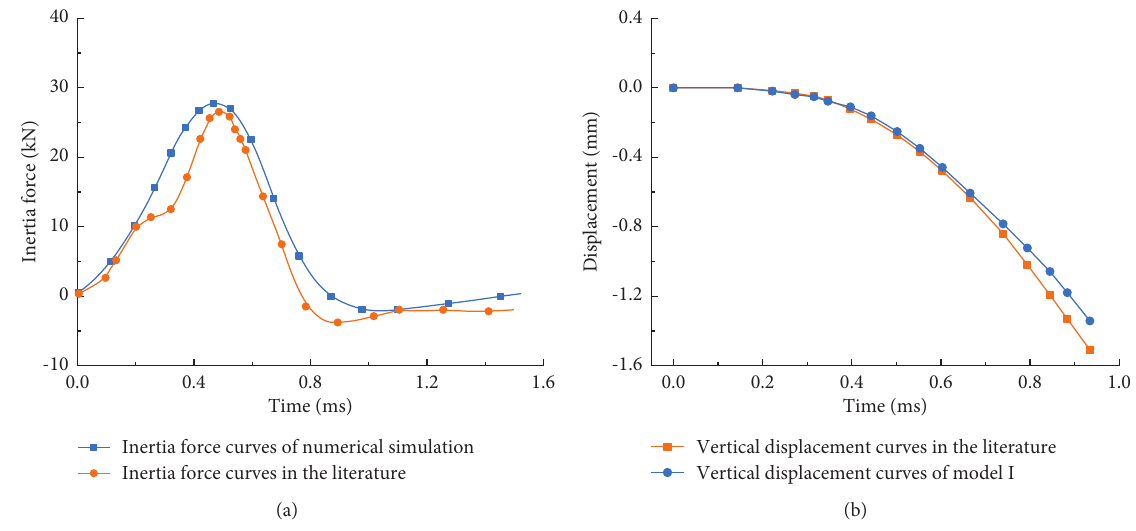
Figure 3: Comparison between numerical simulation and laboratory experiment. (a) Inertia force; (b) vertical